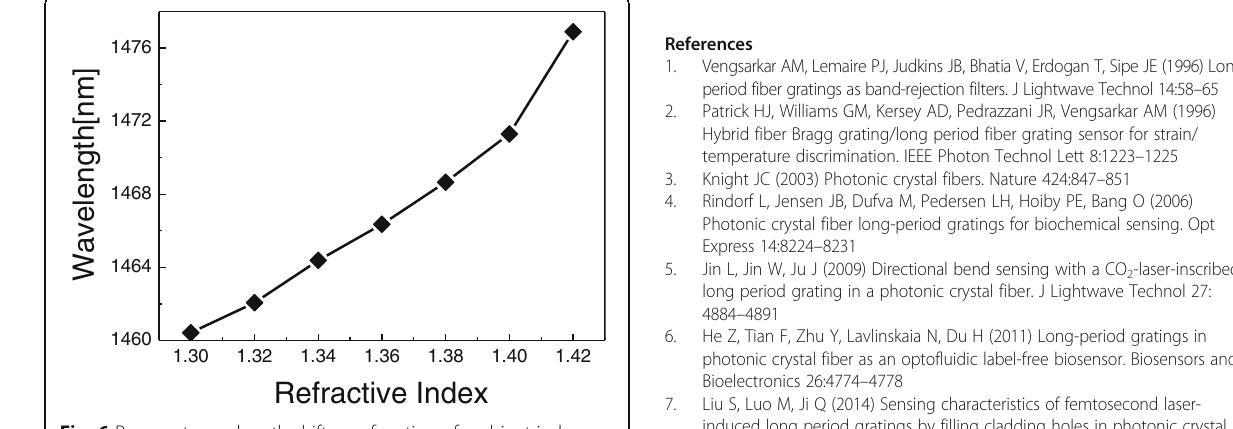
Fig. 6 Resonant wavelength shift as a function of ambient